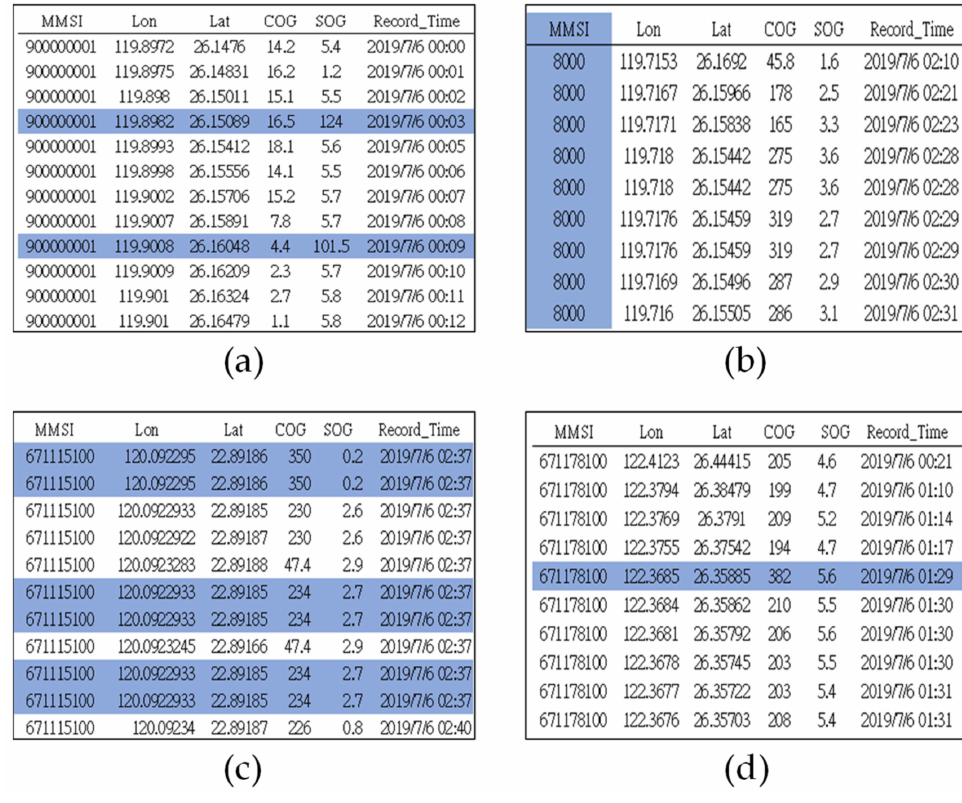
Figure 2. Four types of erroneous and noisy effects. ( a ) Abnormalities exist in the data in the SOG column; ( b ) MMSI column is abnormal; ( c ) Duplicate data; ( d ) Abnormalities exist in the data in the COG